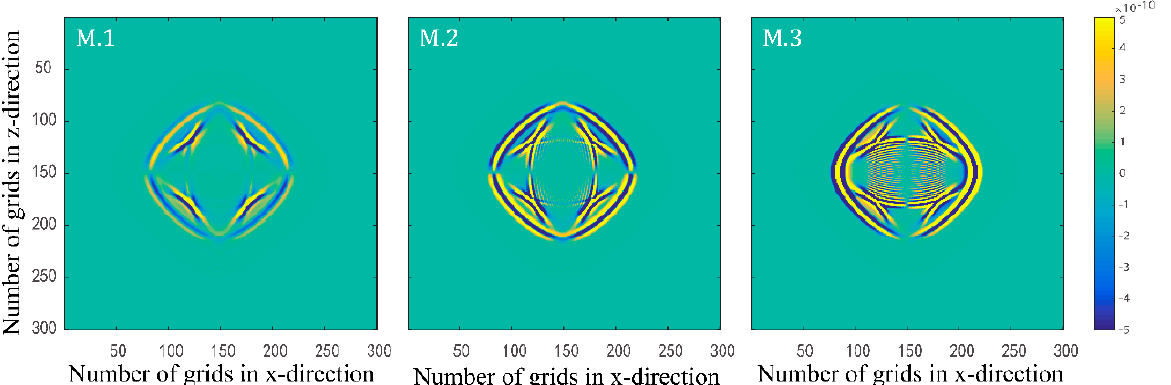
Figure 5. Snapshots of solid–phase z–direction velocity components with three different quality factor groups at t = 0.15 s.